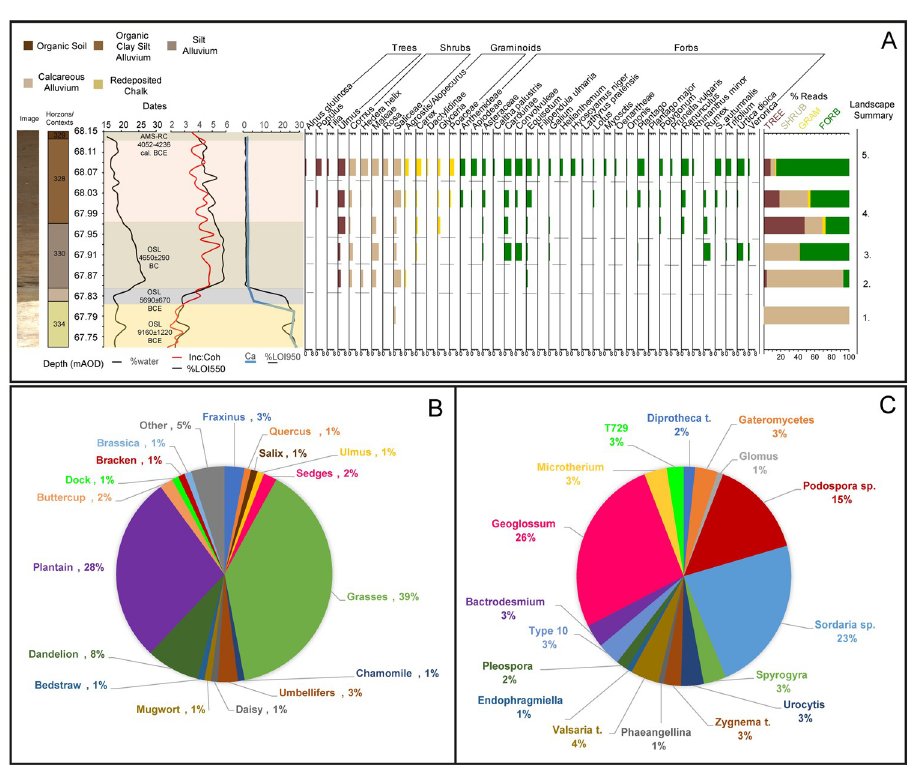
Fig 4. The combined lithostratigraphic and environmental data. A Selected lithostratigraphic data defining the main archaeological contexts and their associated dates. Shown alongside the full plant sedaDNA assemblage displayed as a histogram of the number of PCR replicates and taxa appeared in from 1–8 as well as a composite of total read percentages. The landscape summary determined from the plant sedaDNA evidence is as follows. 1- Willow woodland within floodplain. 2- More open local landscape with willow in floodplain alongside elm and increased shrubs on terrace edge. 3- Open local landscape with slight decrease in wood/shrub taxa, increases in wetland forbs and first appearance of sedge taxa. 4- Continued open local landscape with increased woodland and graminoid diversity, alongside increasing dryland forb community. 5- Continued open local landscape with clear increases in wet and dry woodland, graminoid and forb diversity. B Pollen assemblage taken from the Mesolithic layers of Trench 19 (see text). C Fungal and algal spore assemblage from the same samples.